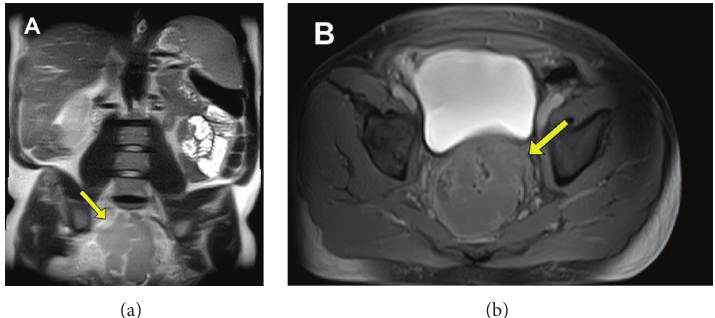
Figure 3: Coronal (a) and axial (b) MRE images demonstrating massive rectal lymphoma and severe narrowing of the rectal lumen (yellow arrows).